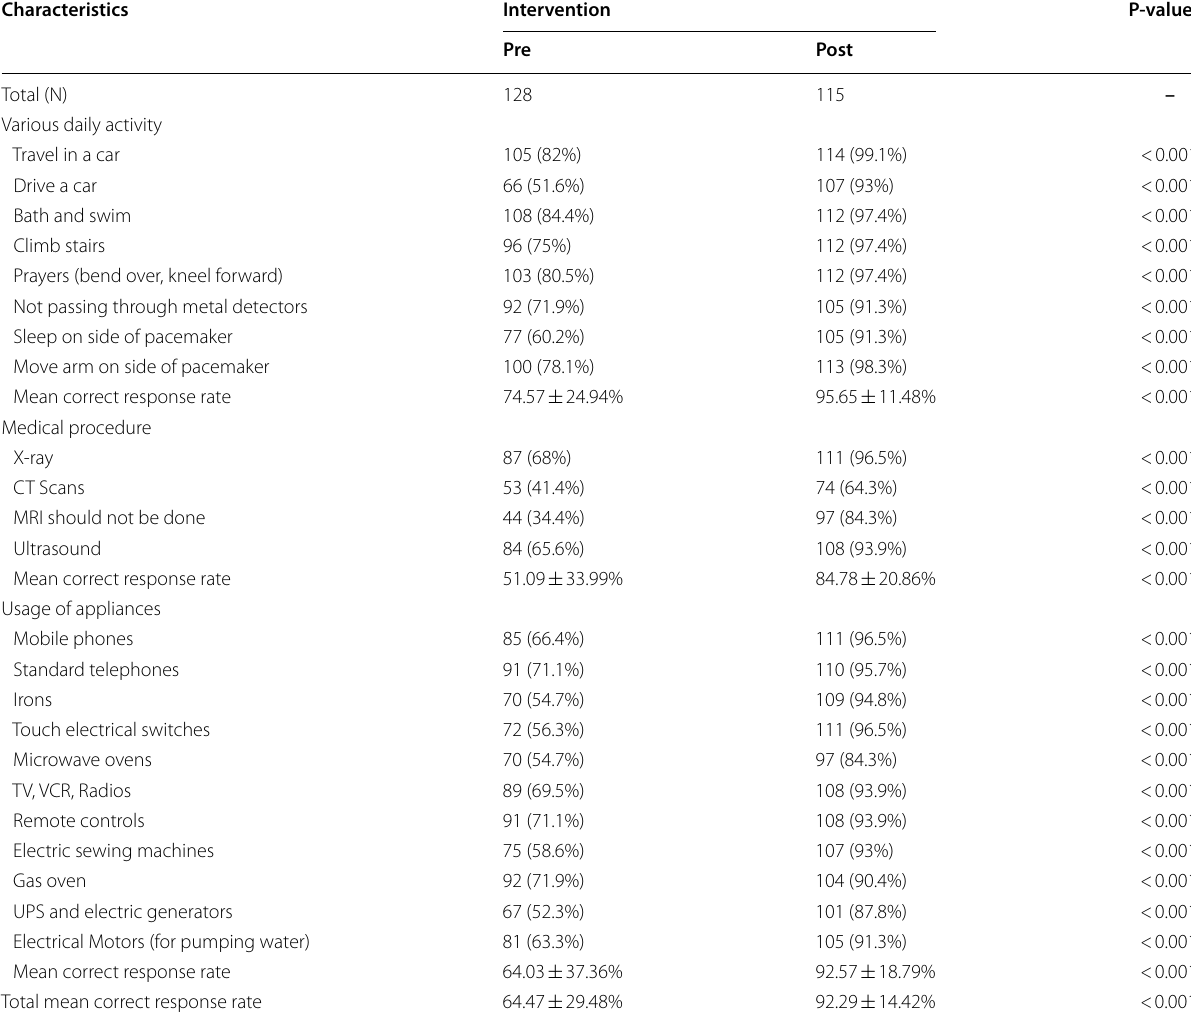
Table 2 Number (%) of patients correctly answering questions on permissible activities pre- and post-intervention